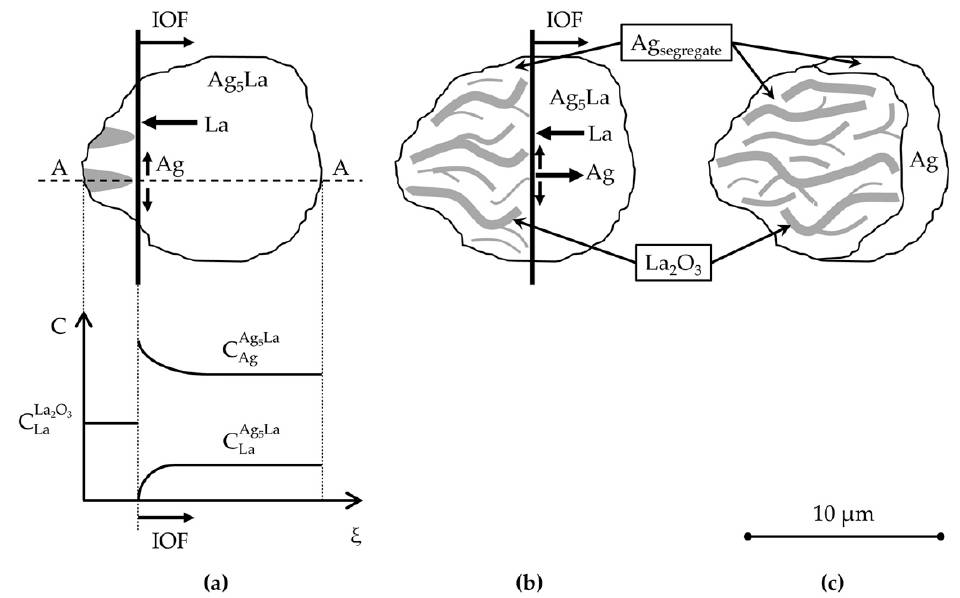
Figure 14. The model of internal oxidation of a “big Ag 5 La particle” in the hypereutectic microstruc- ture with moving internal oxidation front: ( a ) beginning of oxidation with a concentration profile of Ag and La; ( b ) intermediate stage; ( c ) completed oxidation with a crescent on the last oxidised side.